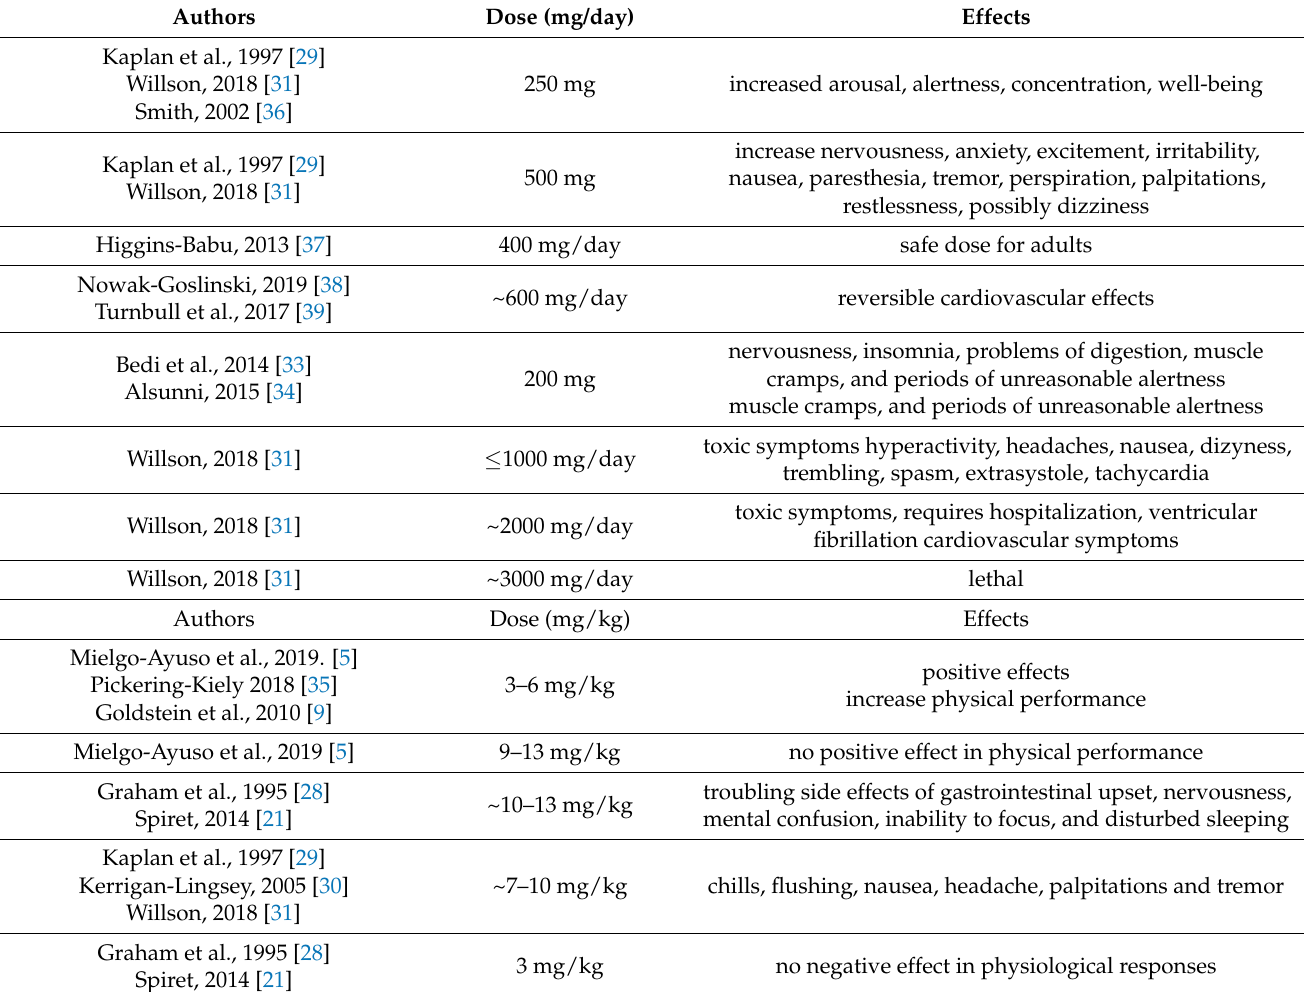
Table 1. Effects of caffeine consumption in different